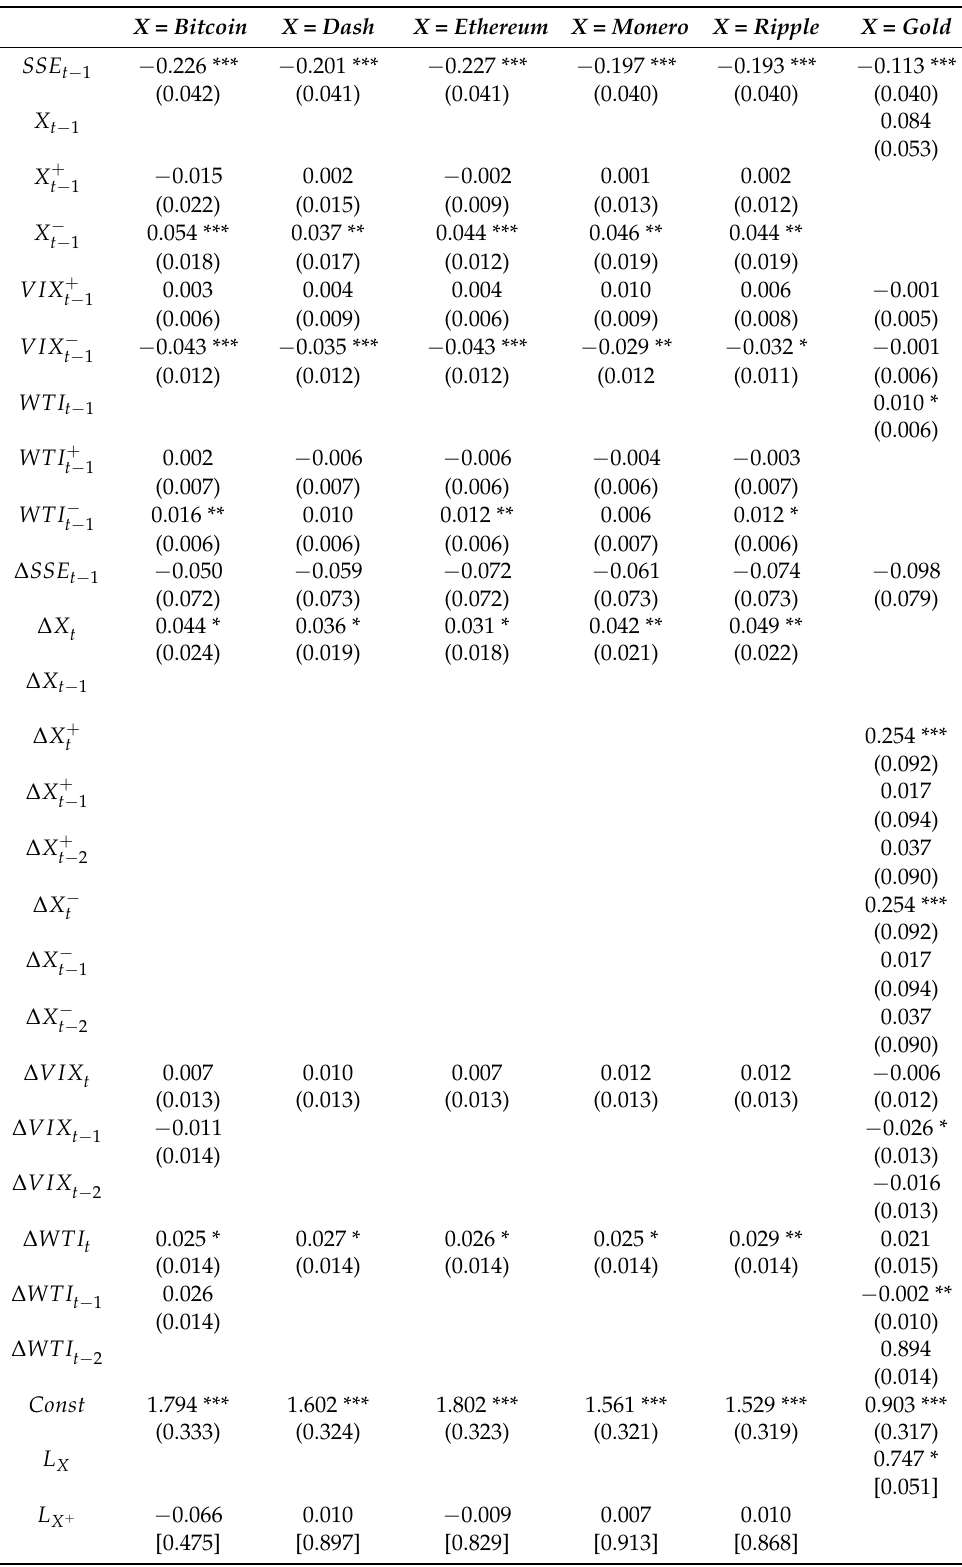
Table 13. Estimation results for SSE during